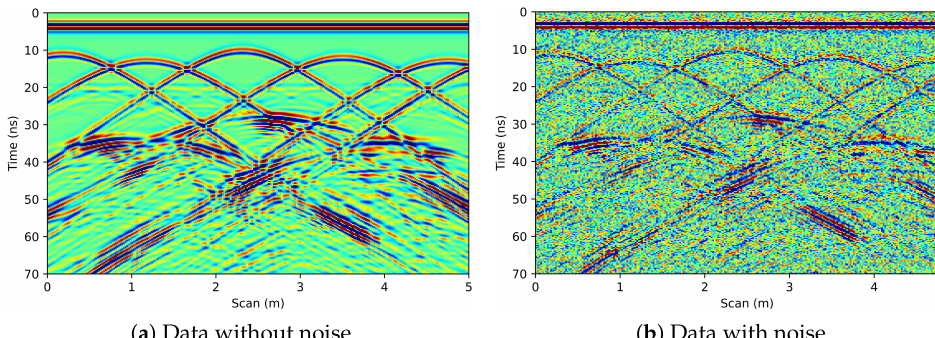
Figure 9. Synthetic profile data of the tunnel lining.